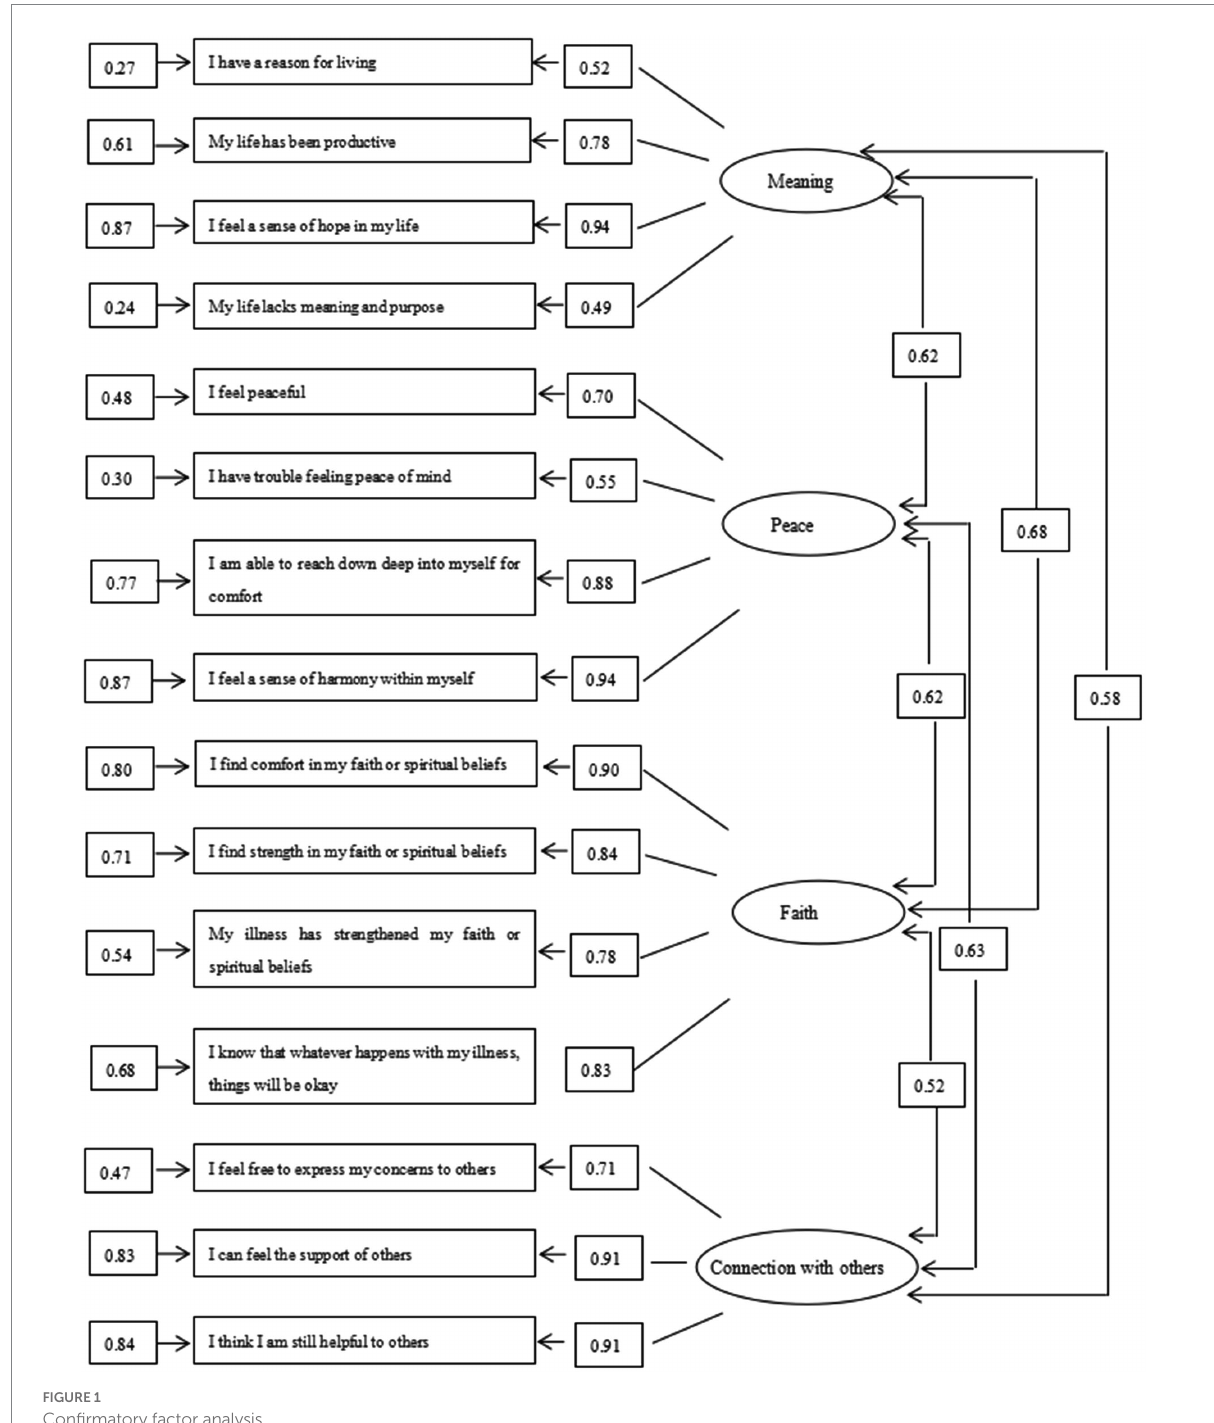
FIGURE 1 Confirmatory factor